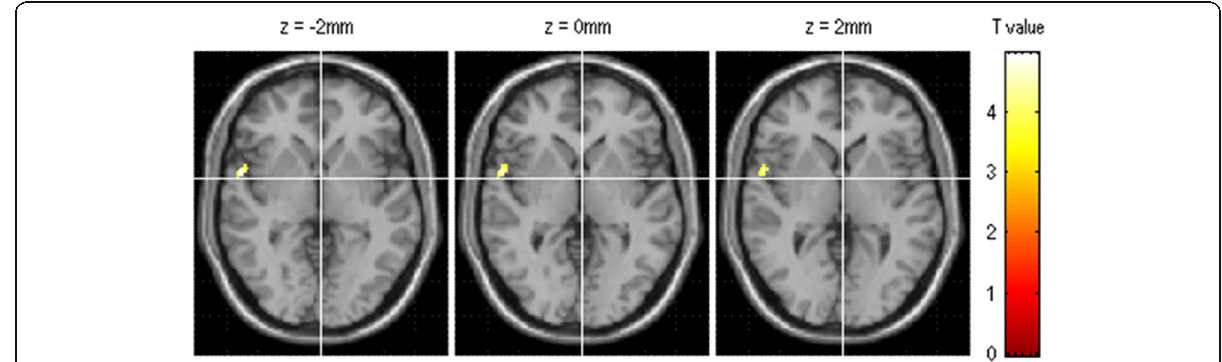
Fig. 3 The brain region with hyperperfusion located in the left superior temporal (BA 38)in EM patients compared with